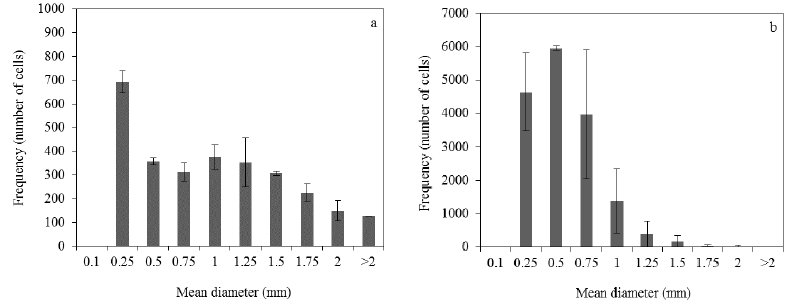
Figure 4. Dispersed clumps diameter distribution at 48 h of submerged fermentation of R. arrhizus NRRL 2582 using 25 g/L initial glucose concentration. The initial ammonium sulphate concentration was ( a ) 0.04 g/L and ( b ) 0.2 g/L.